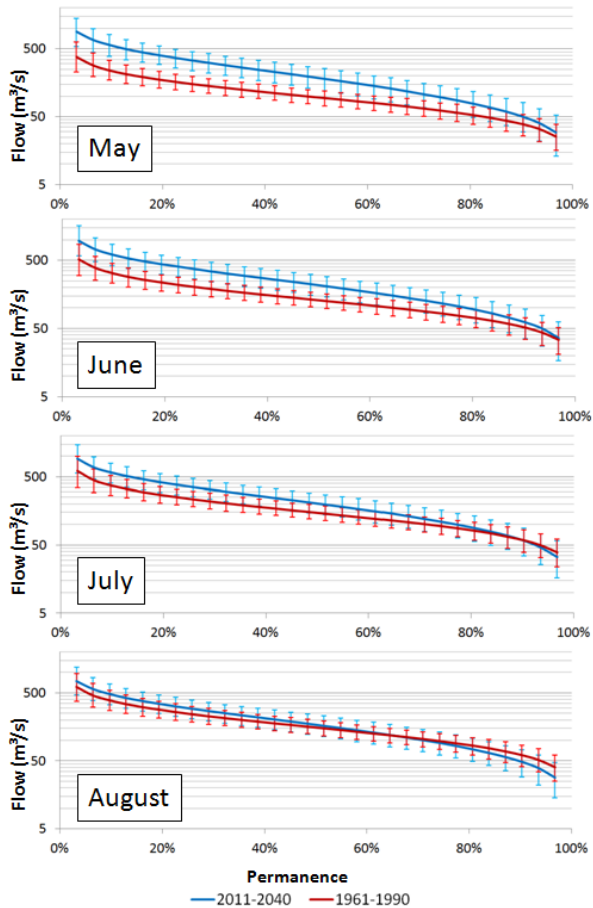
Figure 11. Mean and 90% confidence interval for the monthly flow permanence curves at Santo Ângelo gauge station, according to the stochastic series generated in the base period (1961–1990) and fu- ture period (2011–2040): September, October, November and De-